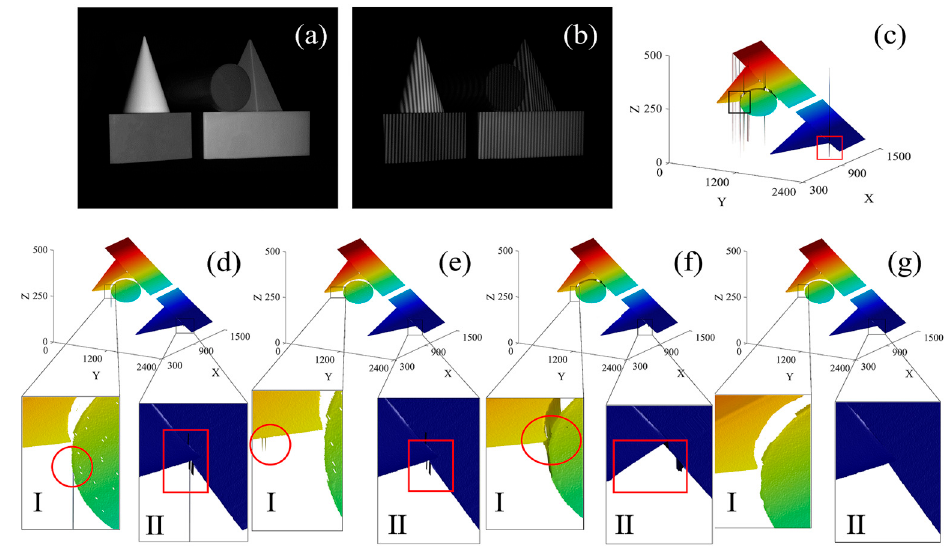
Figure 6. Geometry combination model and its PUE-correction results using the comparison methods and the proposed method, respectively: ( a ) Original image; ( b ) Projected fringe pattern; ( c ) Un- wrapped phase map obtained by Zhu’s method; ( d ) The unwrapped phase map corrected by Ding’s method; ( e ) The unwrapped phase map corrected by Song’s method; ( f ) The unwrapped phase map corrected by Lu’s method; ( g ) The unwrapped phase map corrected by the proposed method.